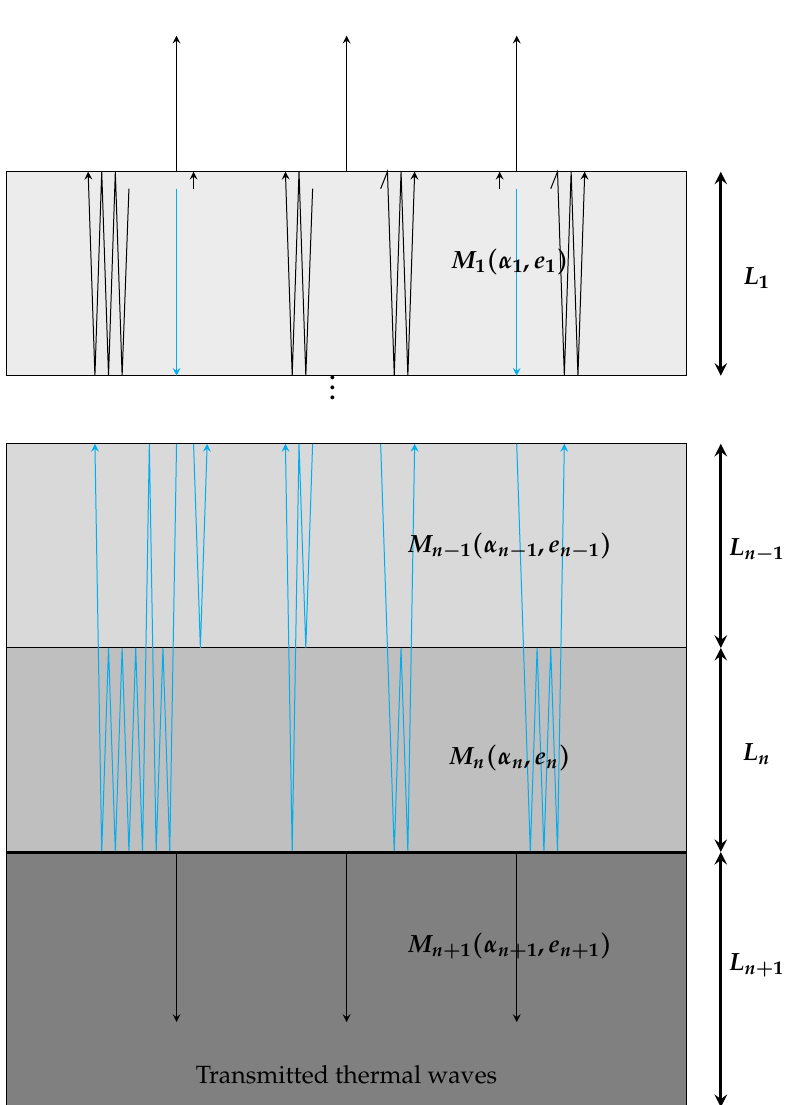
Figure 8. System of n layers of coating materials M 1 – M n and one layer of substrate M n + 1